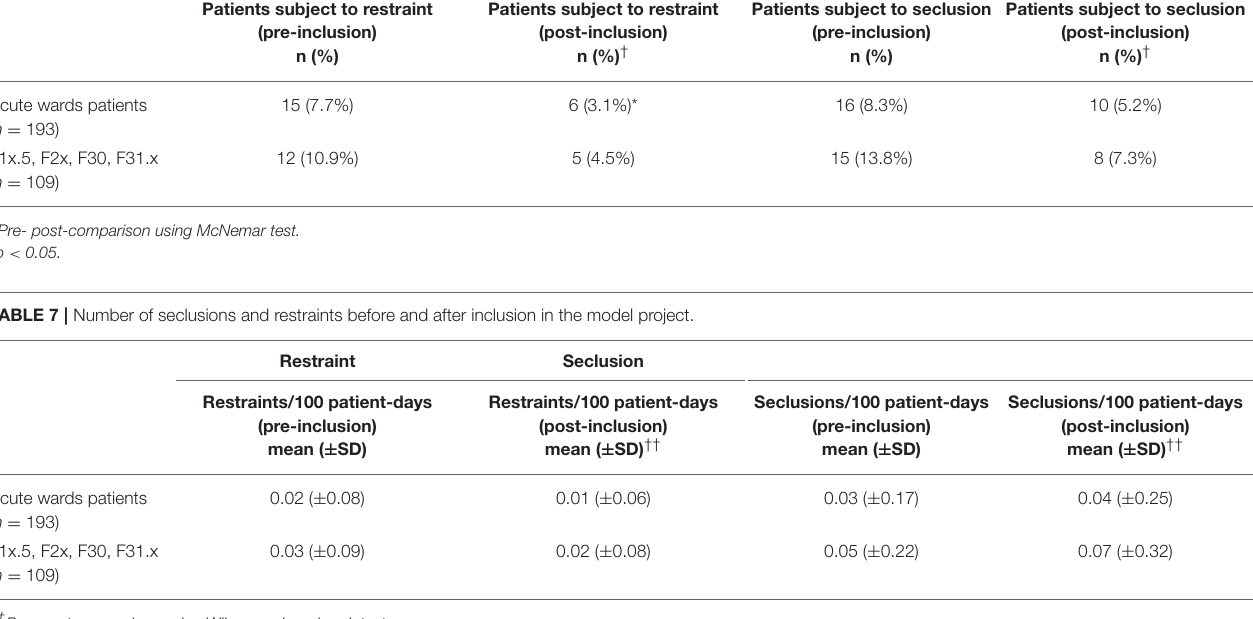
TABLE 6 | Number of patients subject to seclusion or restraint before and after inclusion in the model project. Restraint